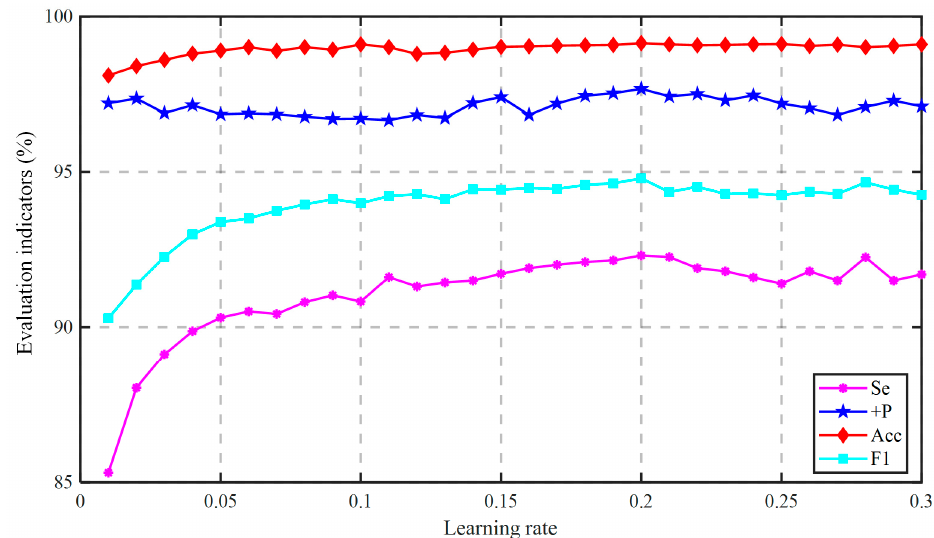
Figure A7. The performance change with the “eta”.